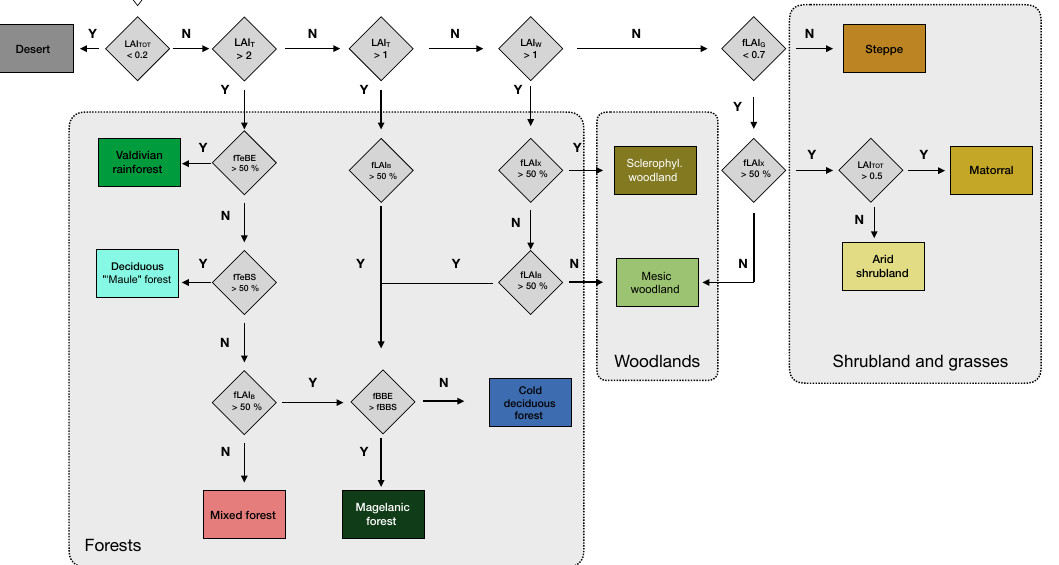
Figure C1. Flowchart of the decision tree used to classify plant functional types (PFTs) into biomes. LAI TOT is the LAI of all PFTs; LAI T is the LAI of tree PFTs; LAI W is the LAI of trees + shrubs; LAI G is the LAI of herbaceous PFTs; LAI X is the LAI of xeric PFTs; LAI B is the LAI of boreal PFTs; fLAI n is the fraction of the LAI PFT n versus its peers (all tree PFTs, boreal PFTs, etc.); TeBE is temperate broad-leaved evergreen trees; TeBS is temperate broad-leaved summergreen trees; BBE is boreal broad-leaved evergreen trees; and BBS is boreal broad-leaved summergreen